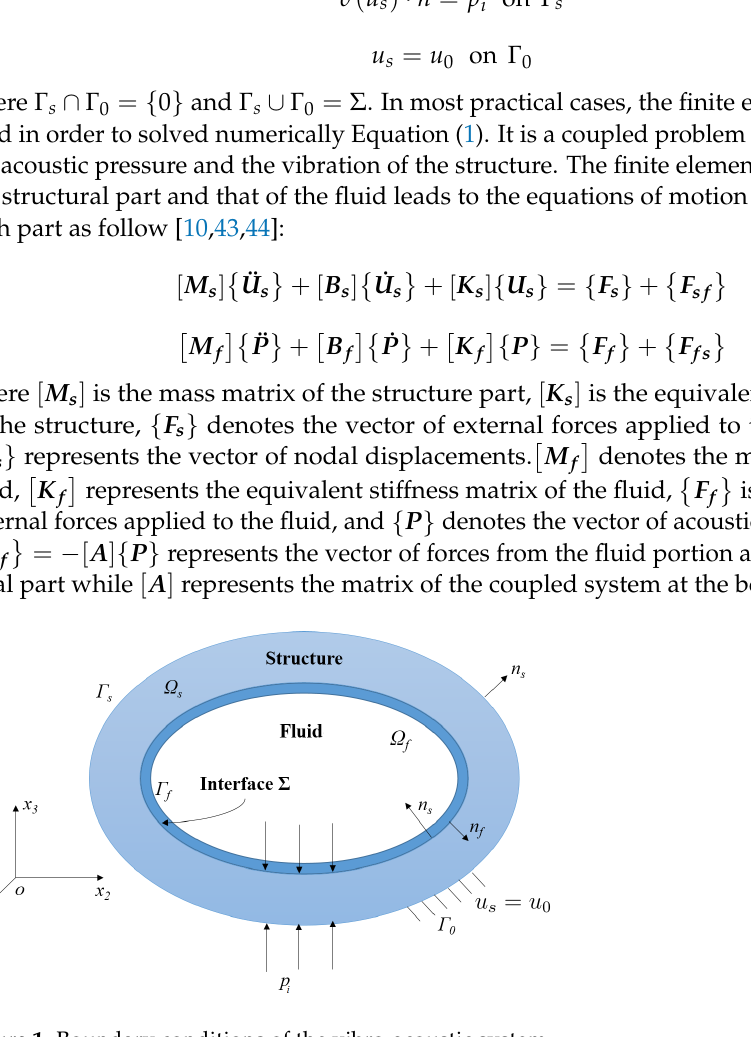
Figure 1. Boundary conditions of the vibro-acoustic